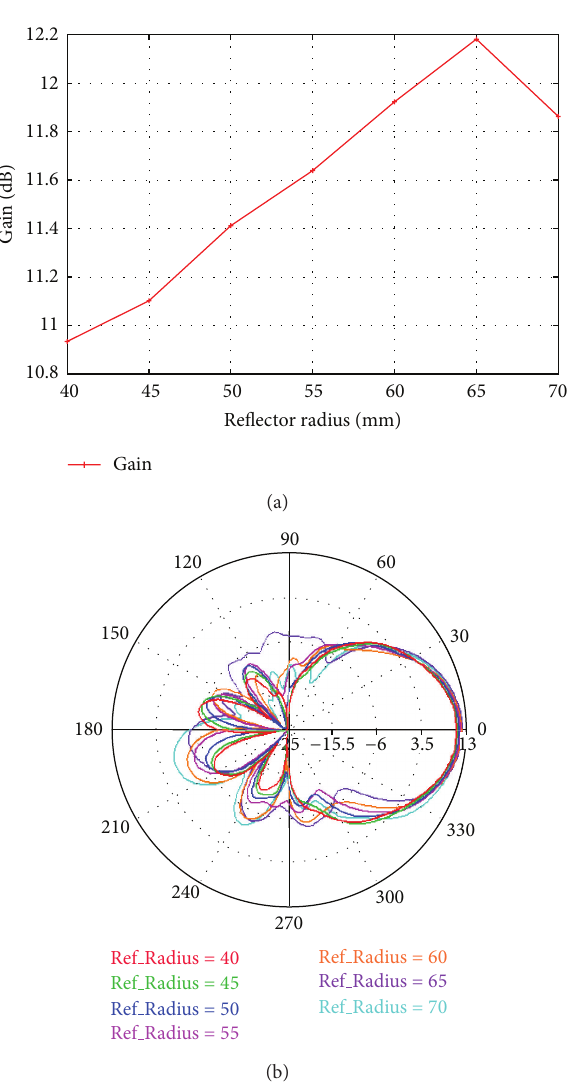
Figure16:SimulatedgainpatternscomputedusingCST:(a)realized gain values and (b) 2D gain